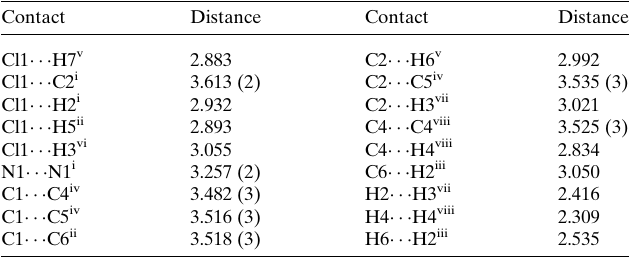
Table 5 Summary of the short interatomic contacts (A˚